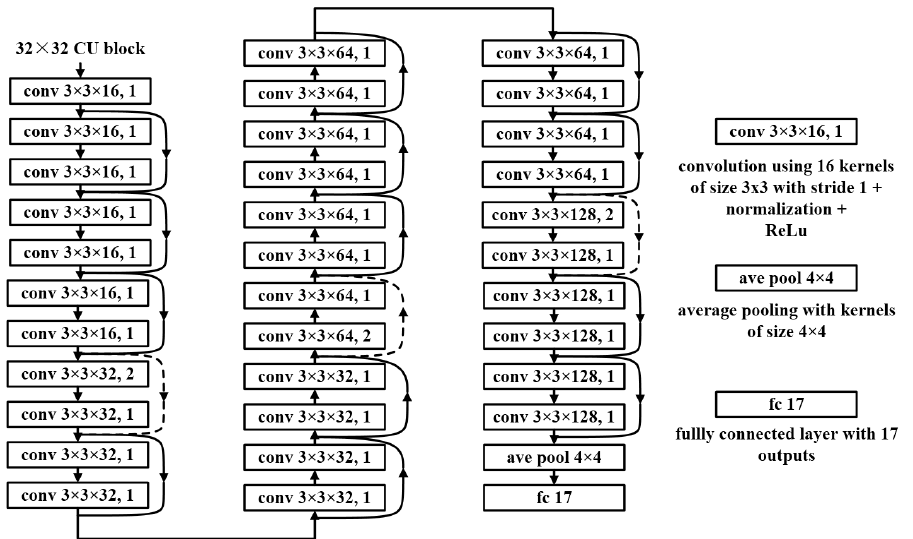
Figure 10. Architecture of the ResNet used in this paper. The dotted lines represent the shortcuts which increase the